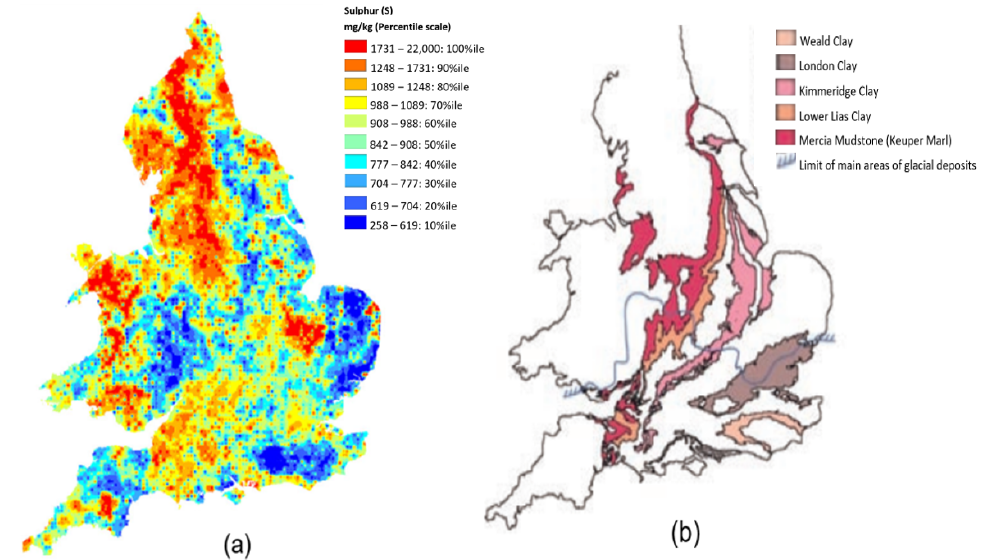
Figure 1. ( a ) National Soil Inventory Topsoil Sulphur Concentrations [20]. ( b ) Major Sulphate/Sul- phide-bearing Strata in England and Wales